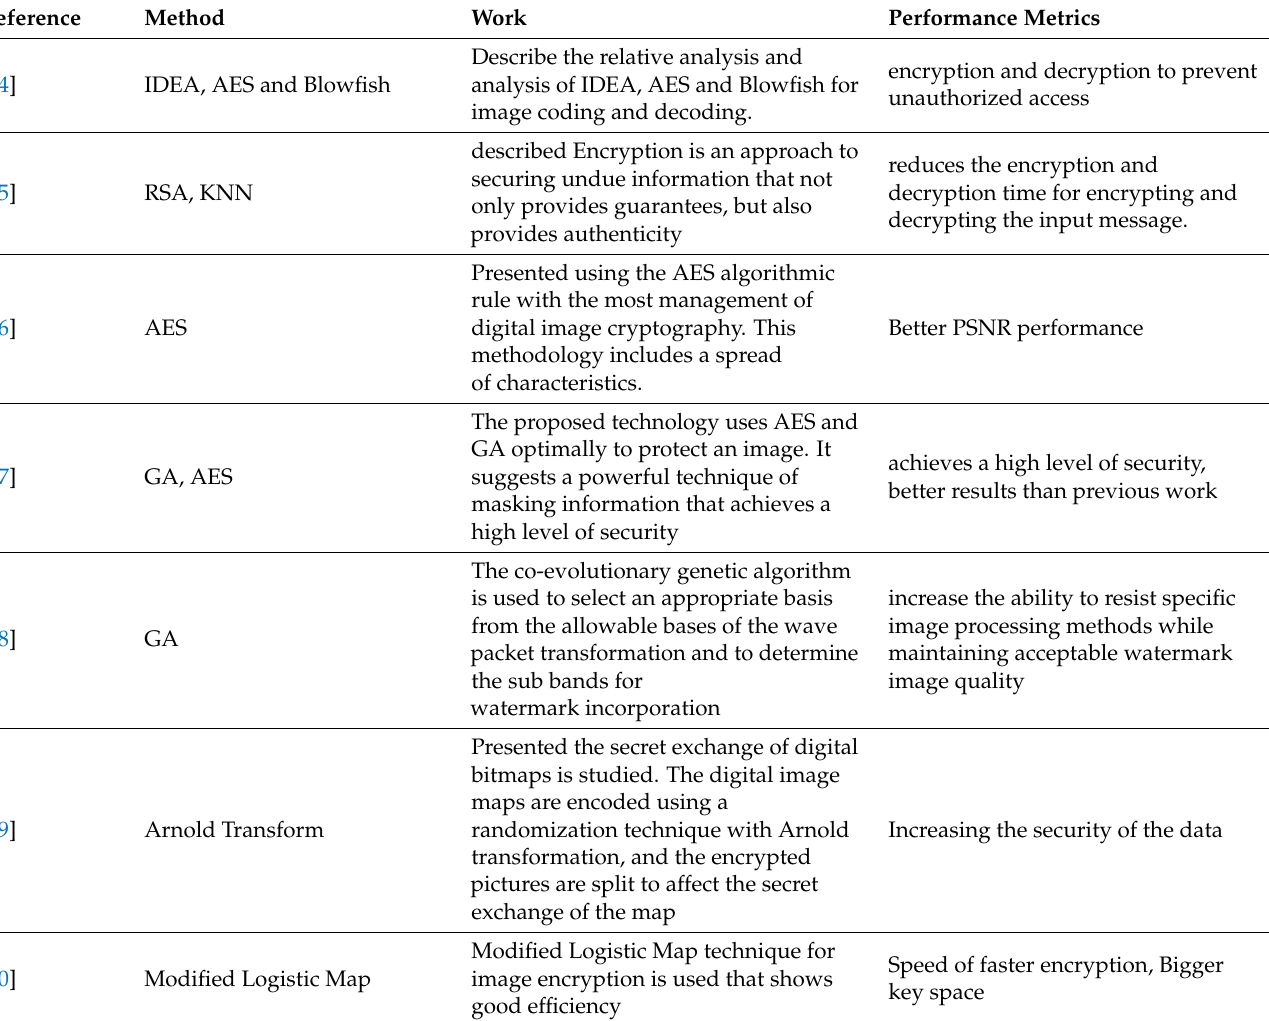
Table 1. Comparison of Existing